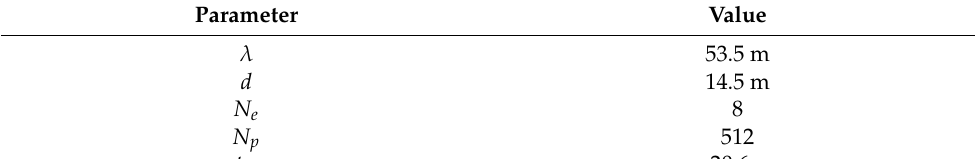
Table 1. System parameters.